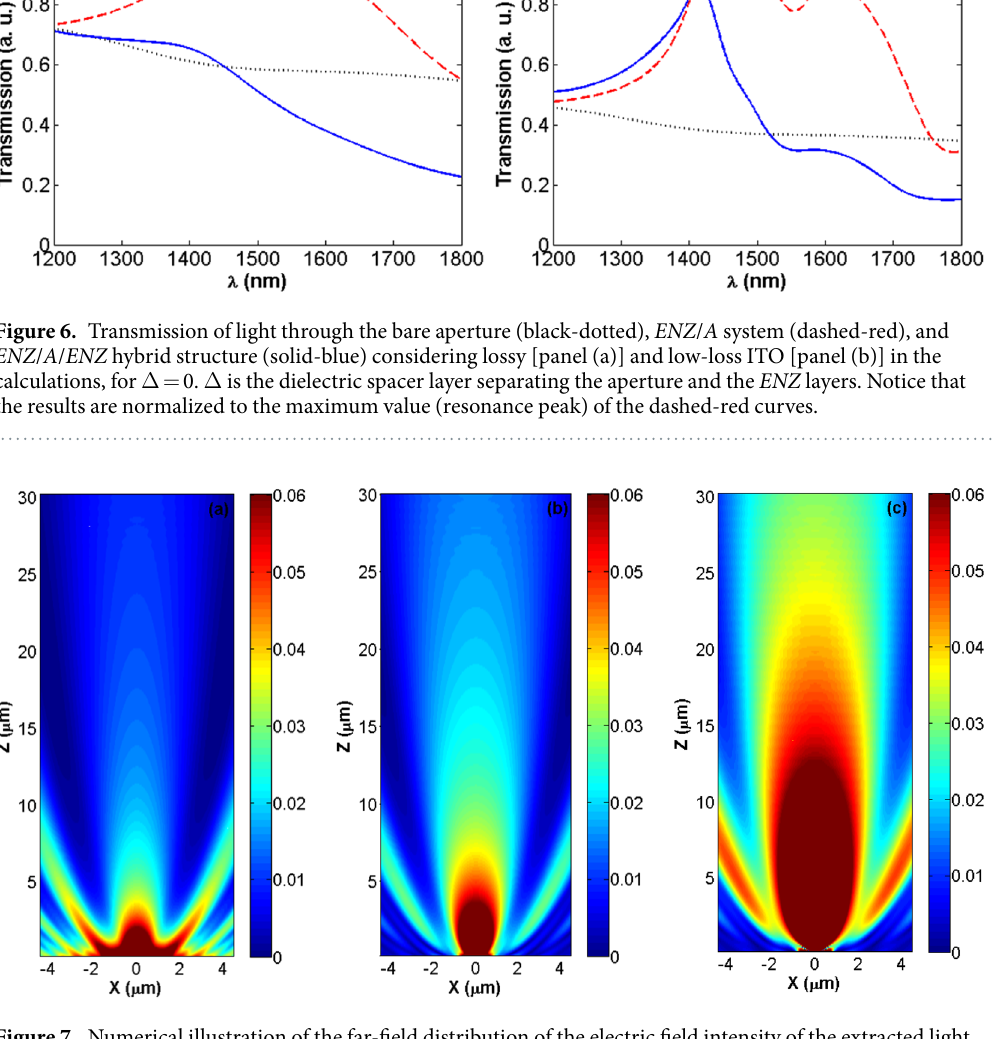
Figure 7. Numerical illustration of the far-field distribution of the electric field intensity of the extracted light from a bare aperture [panel (a)], the one that is covered by a realistic ITO [panel (b)] and low-loss ITO as ENZ media [panel (c)], for Δ = 0 at λ = 1415 nm